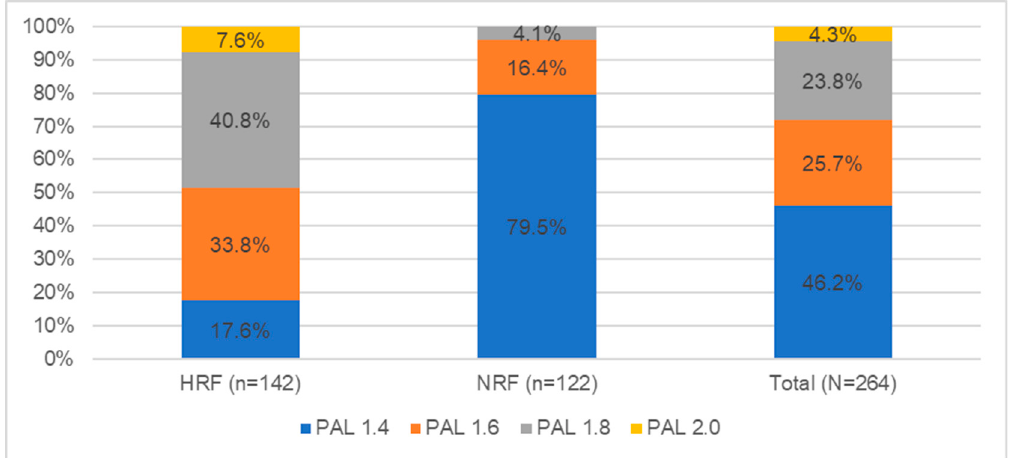
Figure 2. Students’ physical activity level ratings (N = 264).